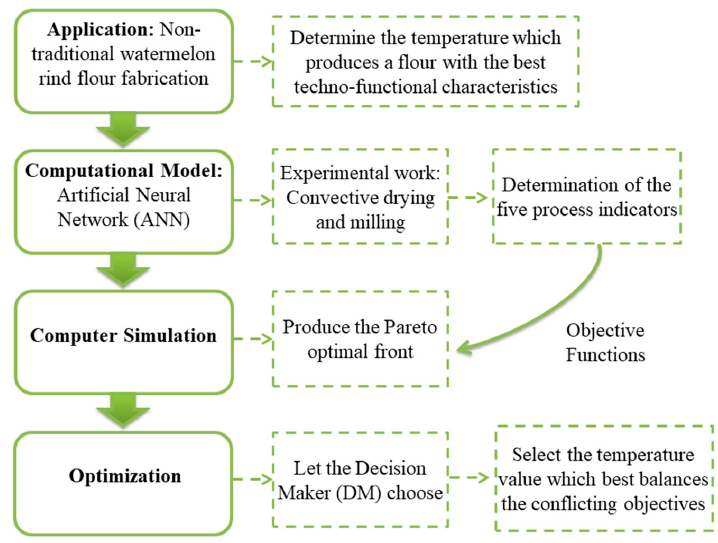
Figure 1. Logic diagram.